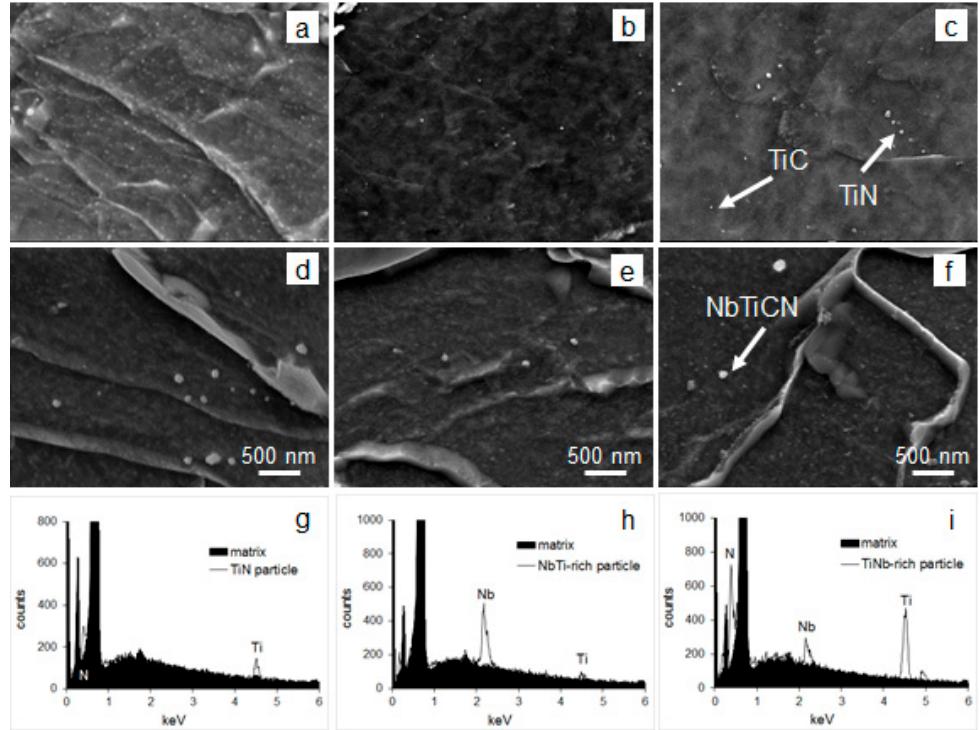
Figure 6. SEM images of precipitates in ( a – c ) Ti ‐ steel and ( d – f ) MoNbTi ‐ steel, after processing according to schedule ( a , d ) A, ( b , e ) B and ( c , f ) C (Figure 1) and EDS spectra of ( g ) TiN particle in the Ti ‐ steel, ( h ) NbTi ‐ rich particle in the MoNbTi ‐ steel and ( i ) TiNb ‐ rich particle in the MoNbTi ‐ steel.